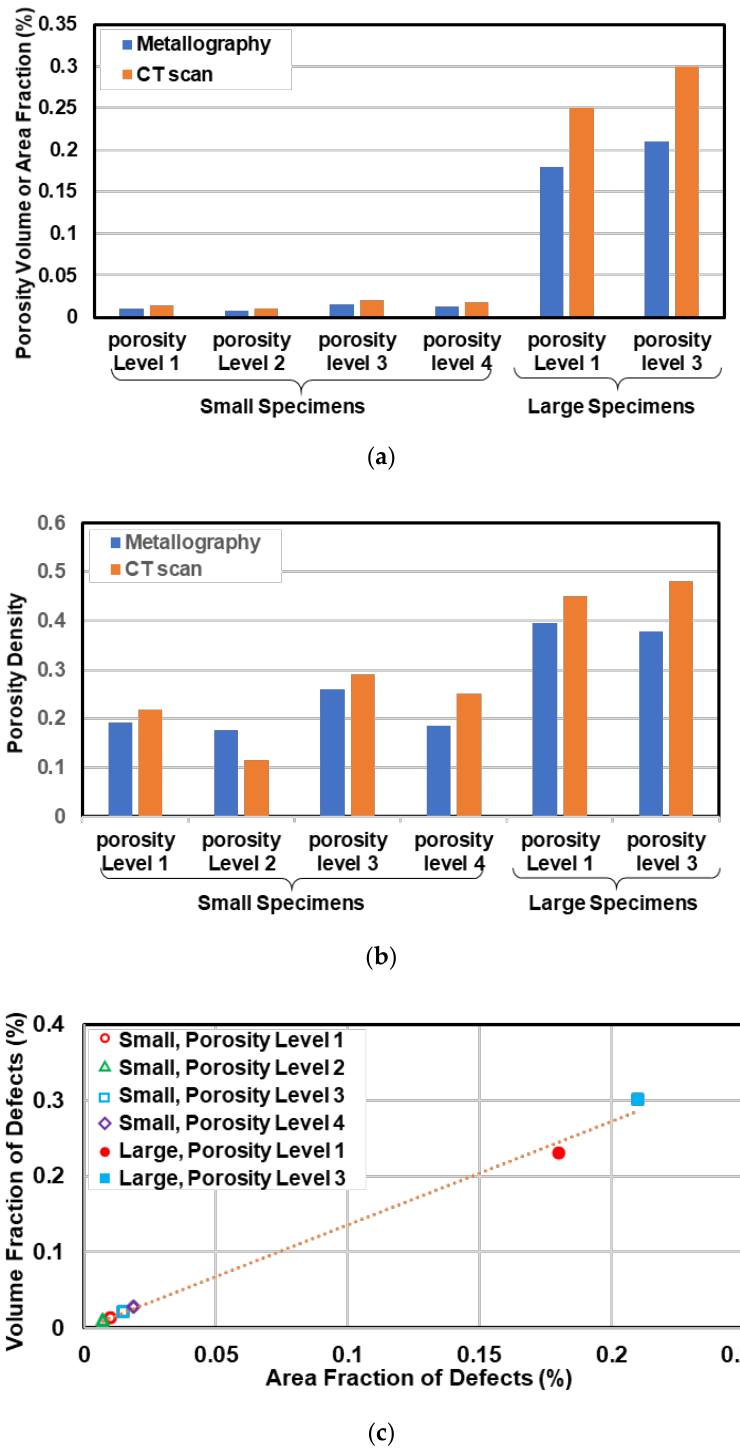
Figure 10. ( a ) volume or area fraction of defects, ( b ) porosity density per mm 3 for CT scan and per mm 2 for metallography data at each porosity level, and ( c ) volume fraction of defects from µCT scan vs. area fraction of defects by metallography.